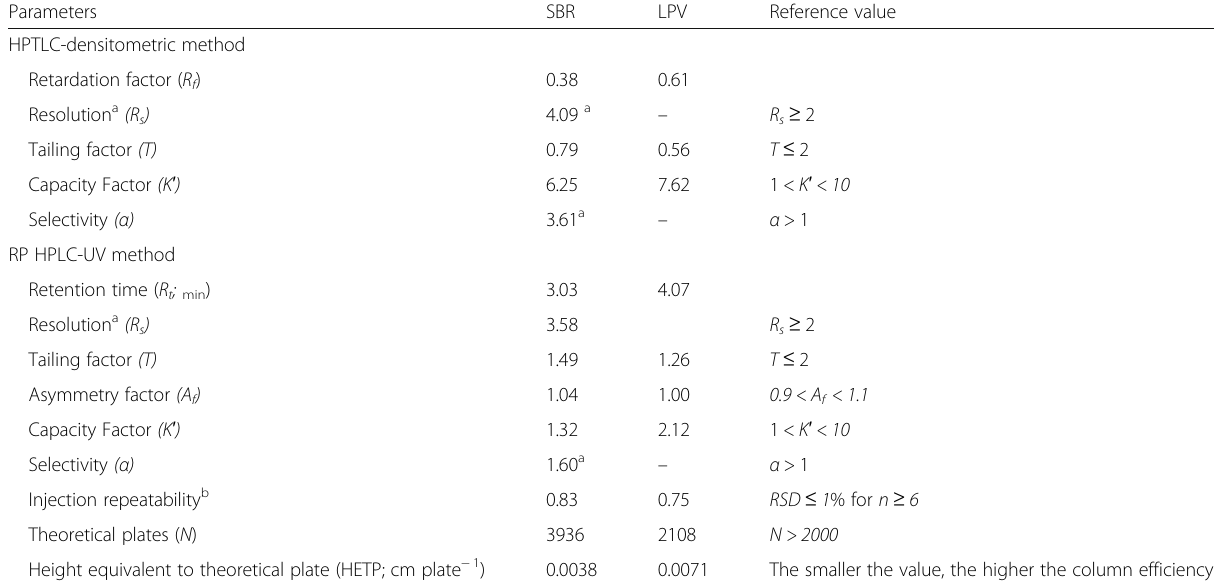
Table 1 Parameters of system suitability testing of the adopted chromatographic methods for the simultaneous determination of SBR and LPV